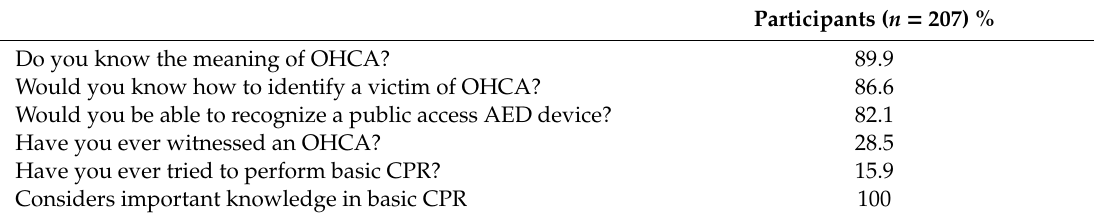
Table 4. Social impact of training in basic cardiopulmonary resuscitation (CPR) and automated external defibrillator (AED)